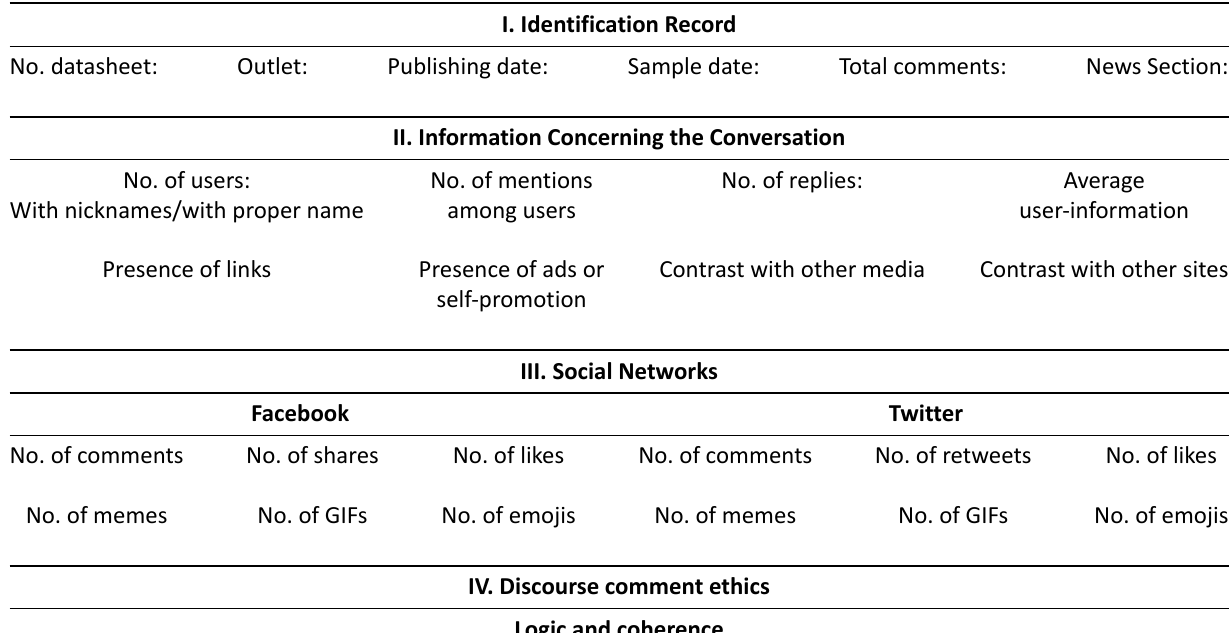
Table 1. User-comments discourse ethics